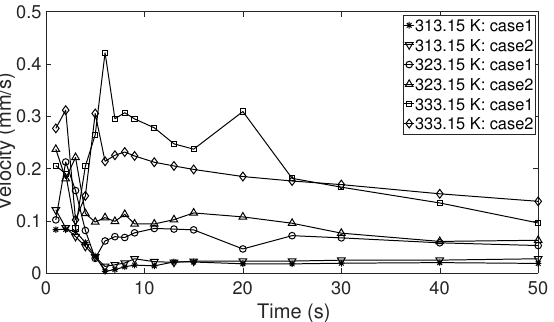
Figure 4. The magnitude of the mean velocity along the symmetry line for T plate = 313.15, 323.15, and 333.15 K when t = 1–50